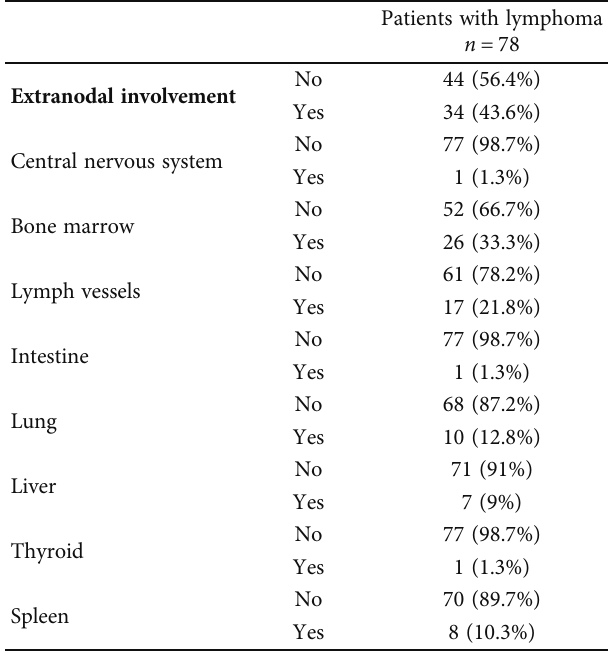
Table 1: Extranodal involvement sites in 34 lymphoma patients.